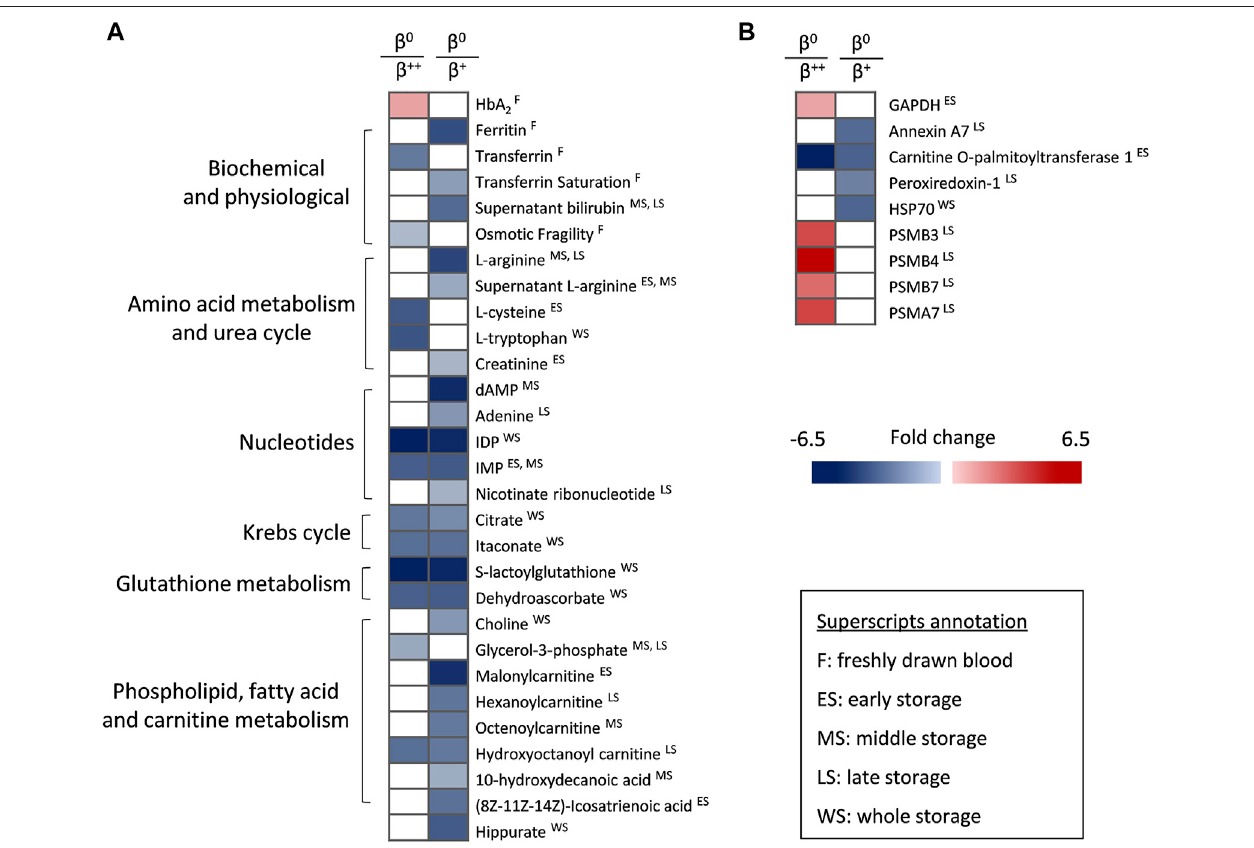
FIGURE4| Statisticallysigni fi cantdifferencesbetween β ++ or β + heterozygotesand β 0 . (A) Biochemical,physiological,metabolicand (B) proteomicdifferences.All differences shown satisfy the criterion of 1.25 fold. n = 2 vs. 8 vs. 2, β ++ vs. β + vs. β 0 . GAPDH: glyceraldehyde-3-phosphate dehydrogenase; HSP: heat shock protein; PSM: proteasome subunit.